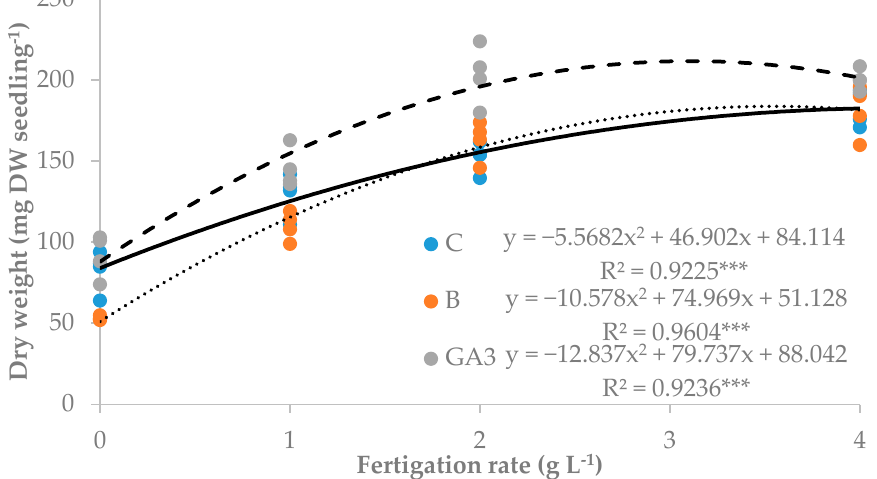
Figure 4. Quadratic predictions of the relationship between the fertigation rates (g L − 1 of NPK 20-20-20) and the seedling dry weight values of untreated (C, continuous line), bacterial inoculated (B, dotted line), and GA 3 -treated (GA3, dashed line) Solanum lycopersicum ‘Marmande’ seedlings (*** significant at p < 0.001). Dry matter percentage was a ff ected only by the fertigation doses with a decreasing trend from − 1 − 1 0 g L to 2 g L (12.4% and 5.9%, respectively), with no further decrease with the highest fertilizer level (Table